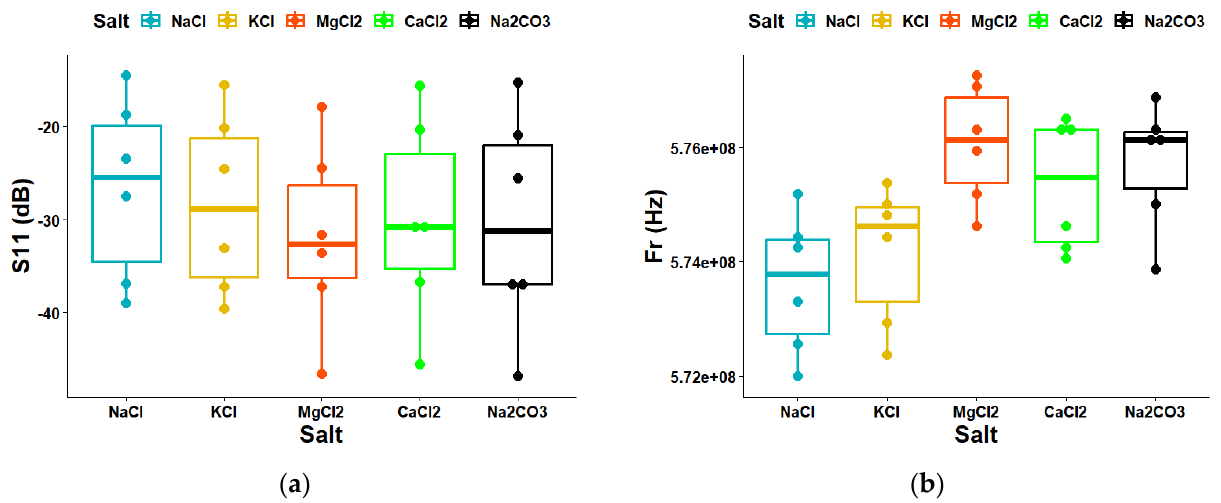
Figure 10. The distribution characteristics of the raw data were compared in each group obtained from the first resonance peak: ( a ) boxplot (S 11 ) and ( b ) boxplot (F r ).